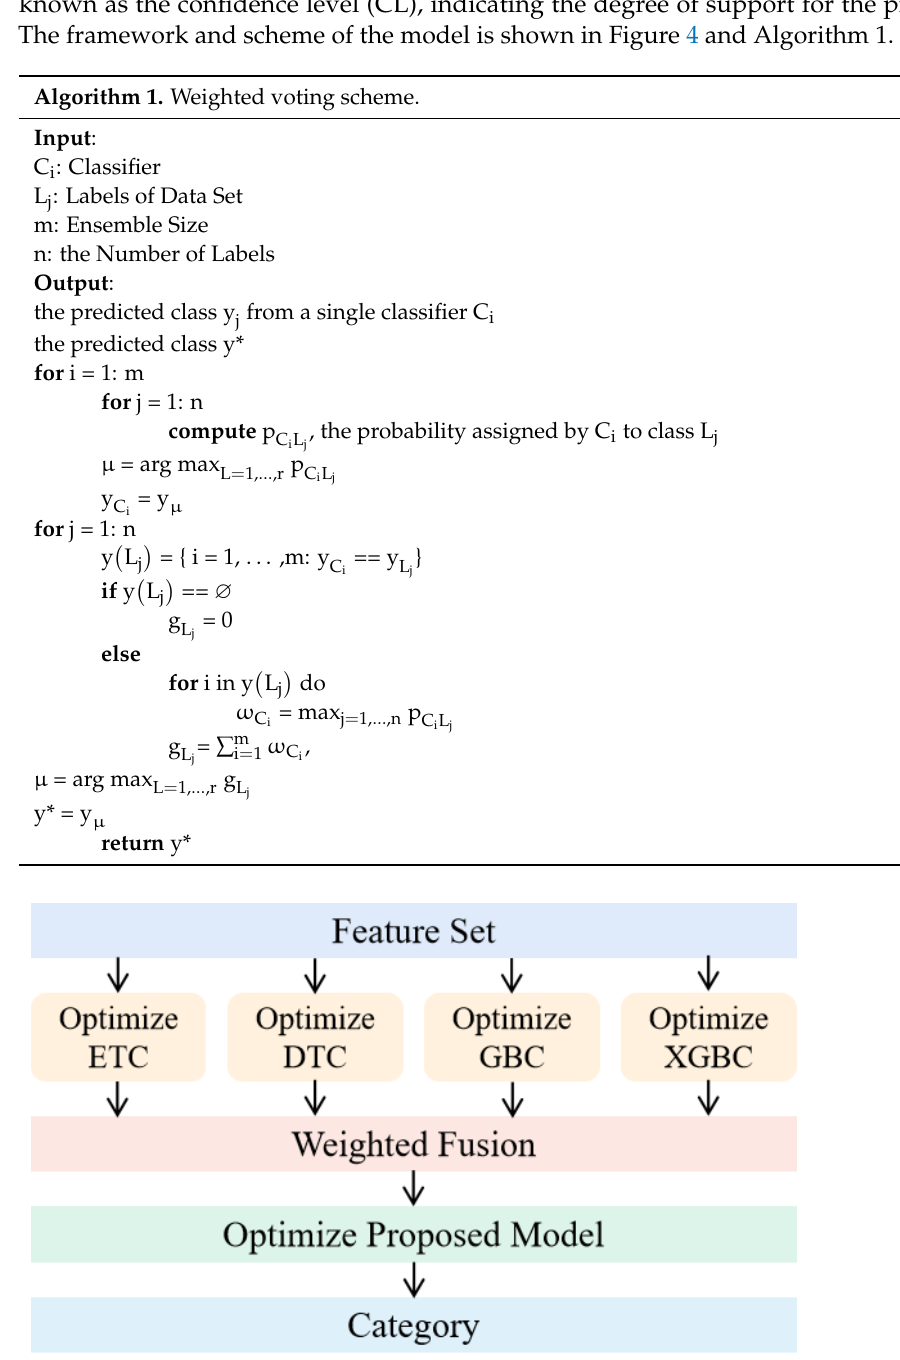
Figure 4. The framework of proposed model.